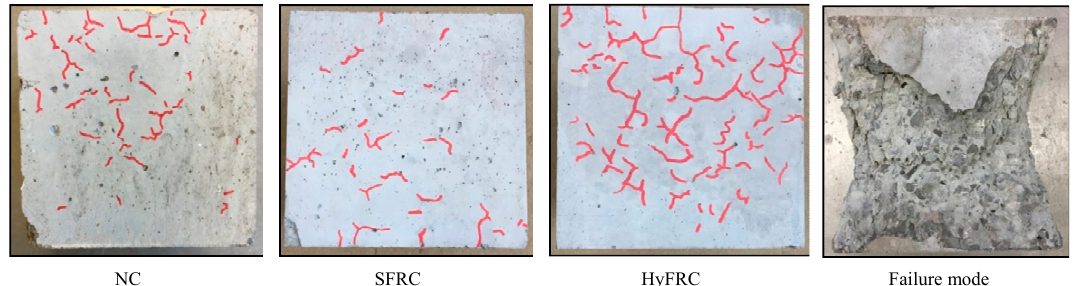
Figure 3. Thermal cracks and typical failure mode observed for the cubes used for compressive strength tests after an exposure to maximum temperature of 600 °C.